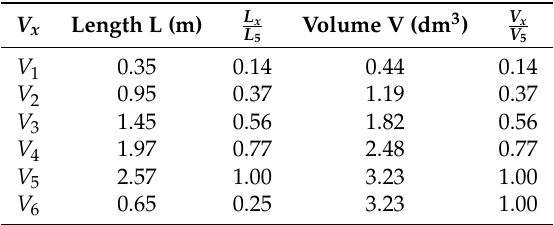
Table 1. Variation of the Plenum